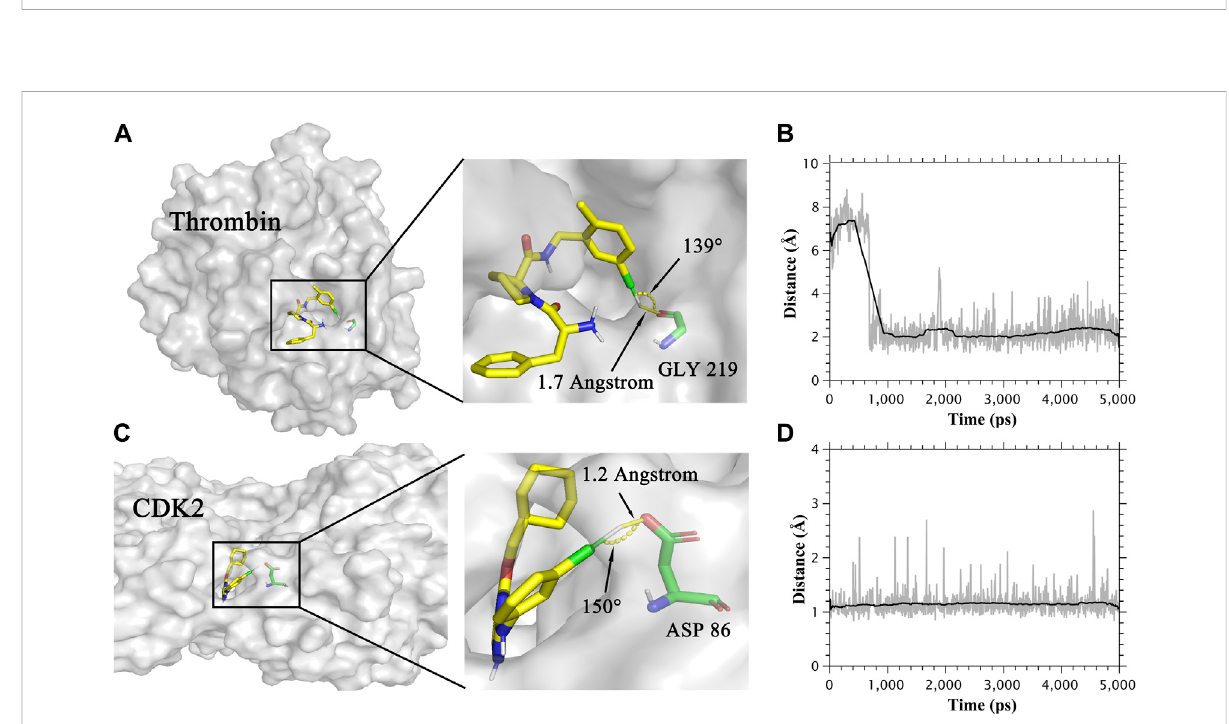
FIGURE 2 (A) The binding mode of Thrombin protein and its ligand. (B) Distance between the oxygen atom and extra point in the halogen bond in the Thrombin system. (C) The binding mode of CDK2 protein and its ligand. (D) Distance between the oxygen atom and extra point in the halogen bond in the CDK2